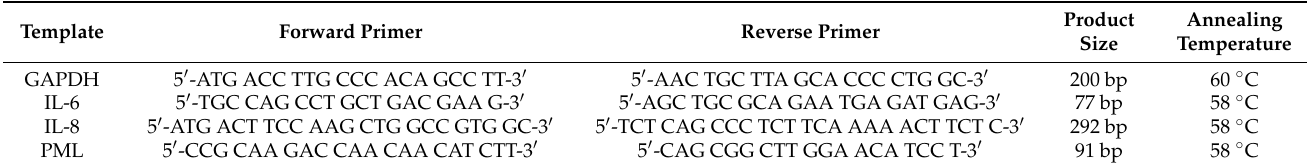
Table 1. Primer sequences, product sizes, and annealing temperatures used to amplify the corre- sponding cDNA